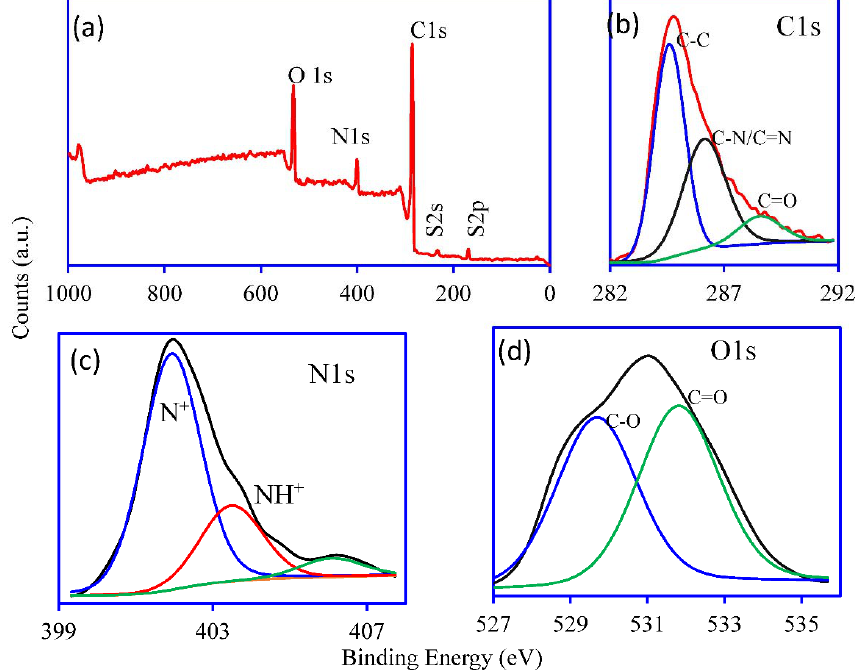
Figure 4. XPS analysis of the PANI/GO@GTW ( a ) wide scan survey and deconvoluted spectra of ( b ) C1s, ( c ) N1s, and ( d ) O1s. The FTIR analysis of the GTW, PANI/GO@GTW, and Br − adsorbed PANI/GO@GTW is included in Figure 5. The FTIR spectrum of the pure GTW shows several absorption peaks for aliphatic C ‐ H groups (2917 and 2844 cm ⁻ 1 ), C = O (1641 cm ⁻ 1 ), and CH 3 sym ‐ metric bending (1523 cm ⁻ 1 ). The absorption peaks at 1442, 1202, 1125, and 1022 cm ⁻ 1 suggest the presence of the NH 2 , CH 2 , C ‐ O, and C = O groups in the pectin, cellulose, and lignin, etc. moieties in the tea waste [33]. After the PANI and GO nanosheet immobiliza ‐ tion, the FTIR spectrum of the PANI/GO@GTW and GTW showed a similar pattern along some new characteristic peaks of PANI and GO. The broad peaks that appear at 1561, 1484, and 1108 cm ⁻ 1 are the PANI benzene rings, while the peaks at 1294 and 789 cm ⁻ 1 correspond to C ‐ N stretching and the out ‐ of ‐ plan vibration of C ‐ H [31]. The peaks for the GO in the PANI/GO@GTW were observed at 1651 (C = C stretching) and 1065 (C ‐ O stretching) [34]. The FTIR spectrum of the Br − adsorbed PANI/GO@GTW showed a simi ‐ lar pattern to the PANI/GO@GTW spectra. A change in the peak position and peak in ‐ tensity of the –OH, ‐ C = O, ‐ N ‐ H, and ‐ C ‐ C ‐ is observed after the Br − adsorption onto PANI/GO@GTW. These results suggest that the change in the peak position and peak intensity is owed to the interaction between Br − ions and diverse functional groups found on the surface of PANI/GO@GTW [33].